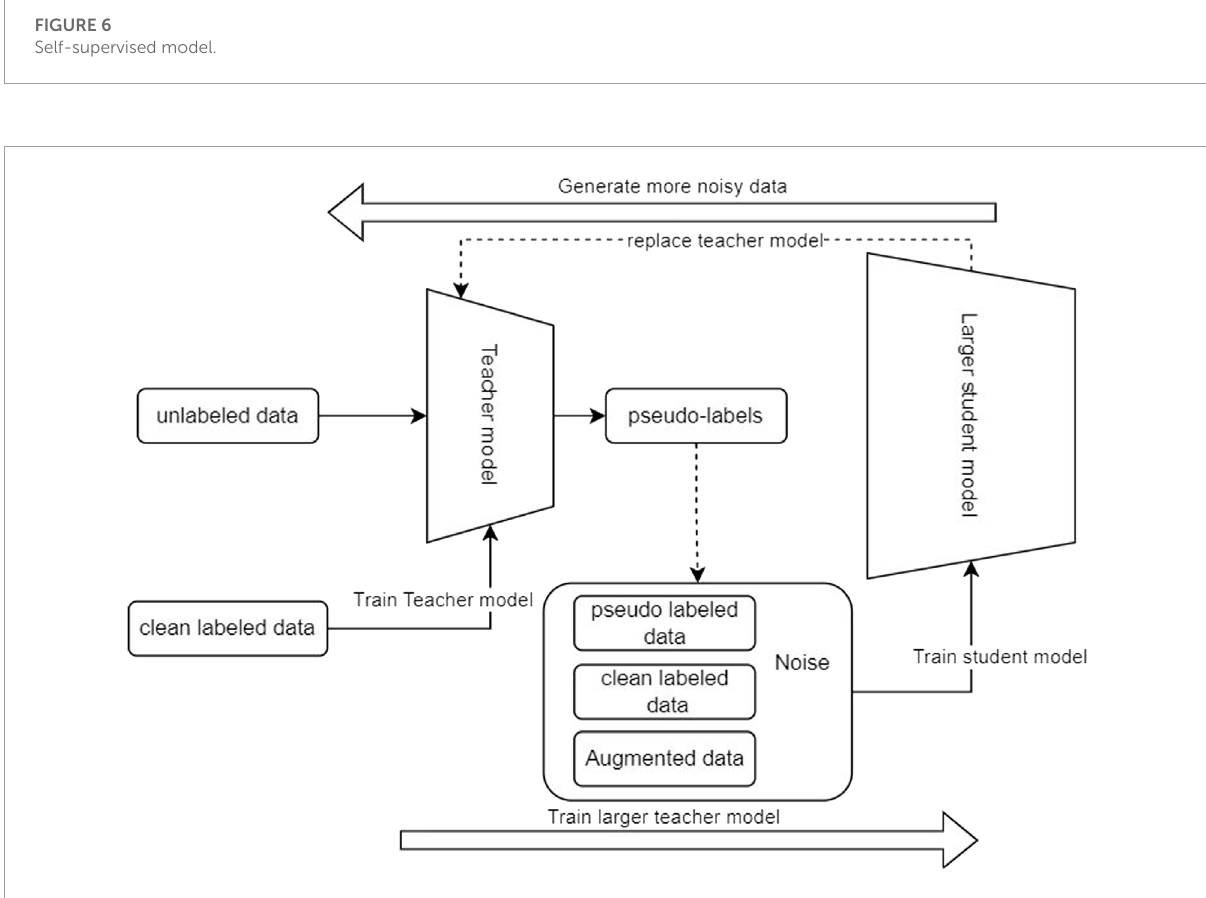
FIGURE 7 Noisy student